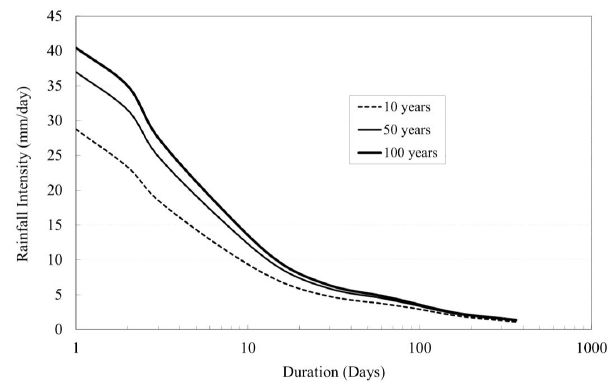
Fig. 4. The rainfall intensity versus duration for different returning periods (10-, 50- and 100-yr). The yield stress and viscosity are two important rheological parameters for modeling the debris flow run-out. Rheological parameters were estimated from empirical data and calibration using historical event data. Empirical coefficients were reported in the FLO-2D manual (FLO-2D Users Manual, 2003). Field survey has suggested that the debris materials are characterized by low viscosity. Therefore we used viscosity coefficient of 0.13, viscosity exponent of 12, yield stress coefficient of 2.7 and yield stress exponent of 10.4 as initial input parameters. Finer calibration was performed with a trial-and-error procedure by comparing with field survey data. The modeling results match well with historical events in terms of traveling path and deposition. However the modeling uncertainty is still a concern when taking into account the different returning scenarios. Adequate data are necessary to improve the frequency-magnitude analysis of debris flow hazard and rainfall analysis, as well as to help validate modeling. The modeling predicts the flow depth, hydrostatic pressure and dynamic pressure of the simulated widespread debris flows. The results related to rainfall with returning period of 100 year are presented in Fig. 5. Such results help identify the high hazard zone in the study area and further define the low hazard area (Fig. 2). The simulation of potential debris flow events shows that flow velocity still keep at a destructive level in places 200 – 500 m away from the gully outlets. Accordingly, areas less than 200 – 500 m away from the outlets of those gullies without any reduction measures are regarded as high hazard zone. While for those gullies with reduction measures (e.g. dykes), the influencing radius (outlet as the center) of debris flow could reduce to 50 m. According to Fig. 2, some parts of the settlement area actually locate beyond the low hazard area. It could be suggested that the consideration of this restriction in the reconstruction of Jiegu township is capable of avoiding potential severe geological hazards after YE .